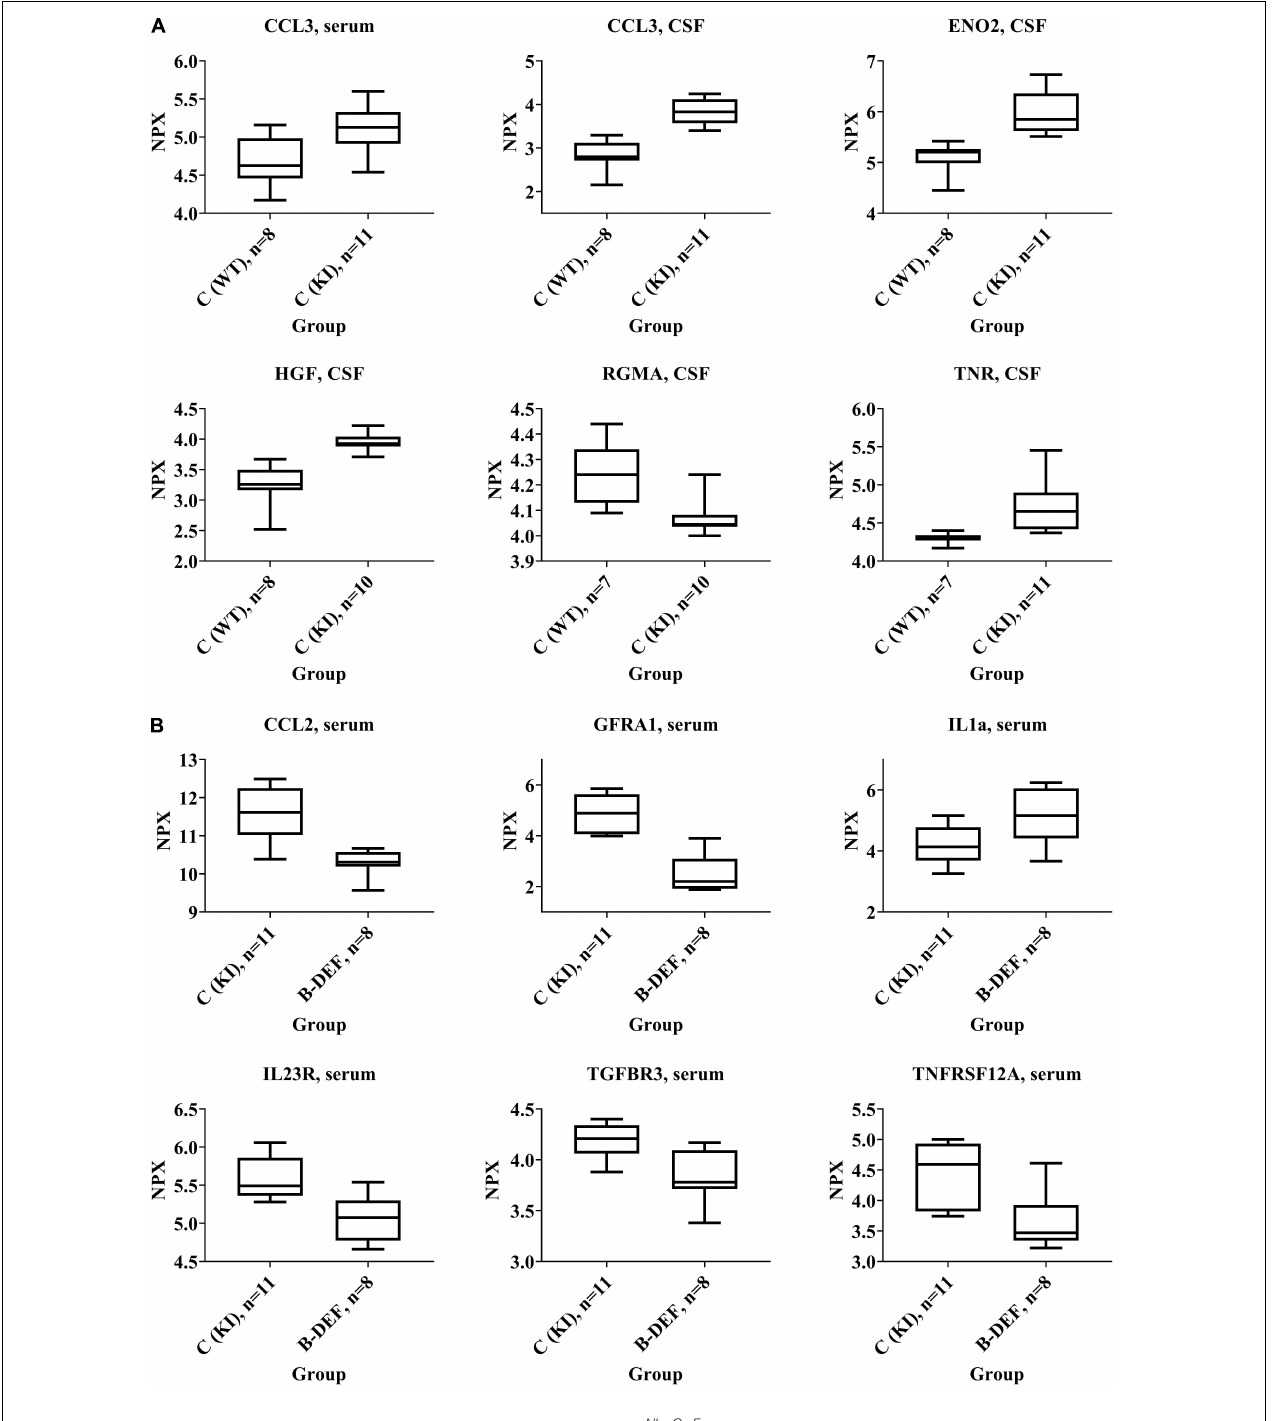
FIGURE 7 | Selected protein biomarkers that were differentially regulated in (A) App NL − G − F knock-in versus C57BL/6J wild type mice and (B) hyperhomocysteinemic versus control App NL − G − F knock-in mice; age 67–68 weeks; differences in the protein quantities depicted here did all reach statistical significance ( p -values < 0.05); normalized protein expression (NPX) is an arbitrary unit on log2-scale; high NPX means high protein concentration.